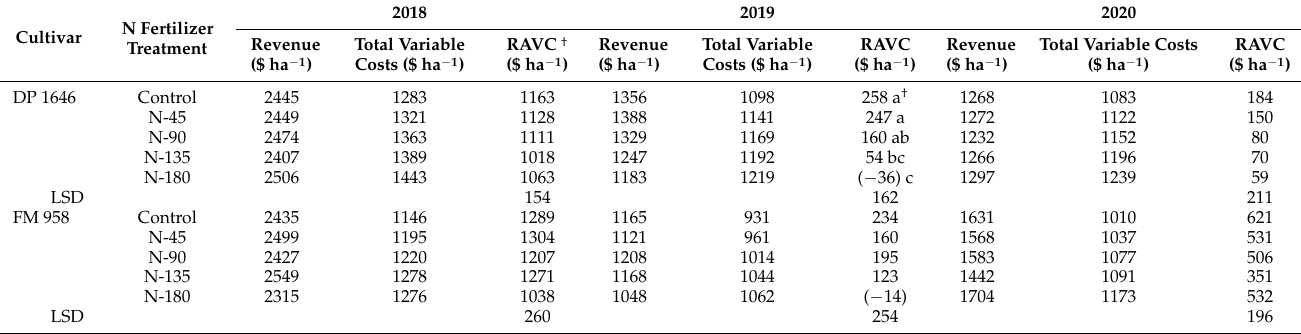
† For each cultivar and year, RAVC means within a column annotated by different letters are significantly different at p <